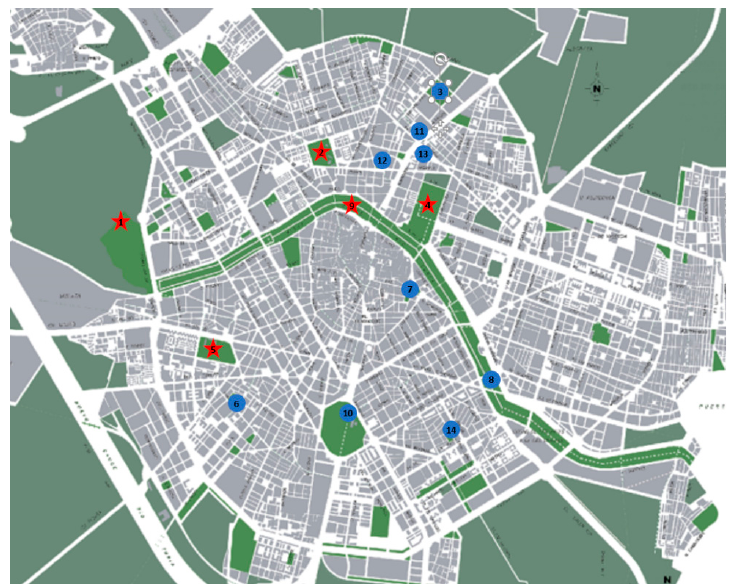
Figure 1. Map of the metropolitan area of Valencia, highlighting the positive (red stars) and negative (blue circles) parks to Toxocara spp. eggs. Numbers inside correspond to references to the park according to Table